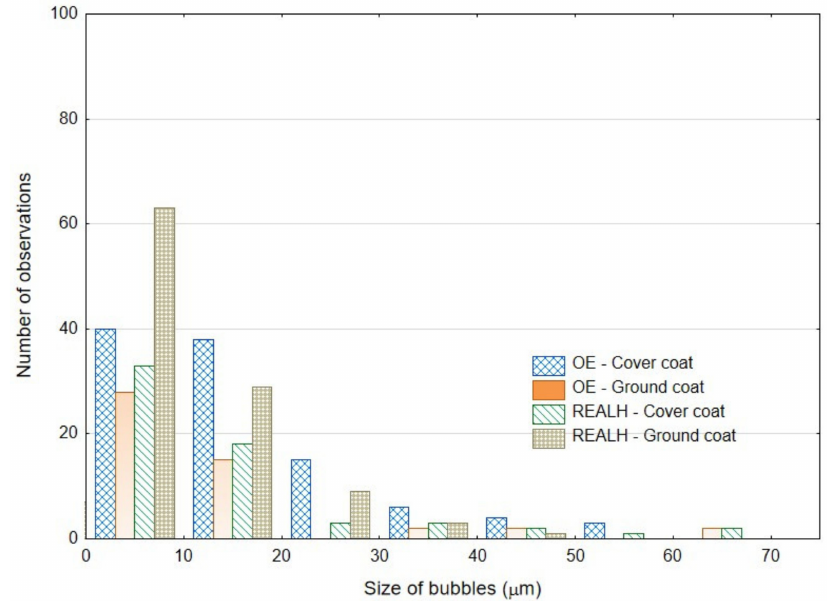
Figure 5. Bubble size in the enamel layer (Original enamel—OE, Renovated enamel applied by local heating—REALH).